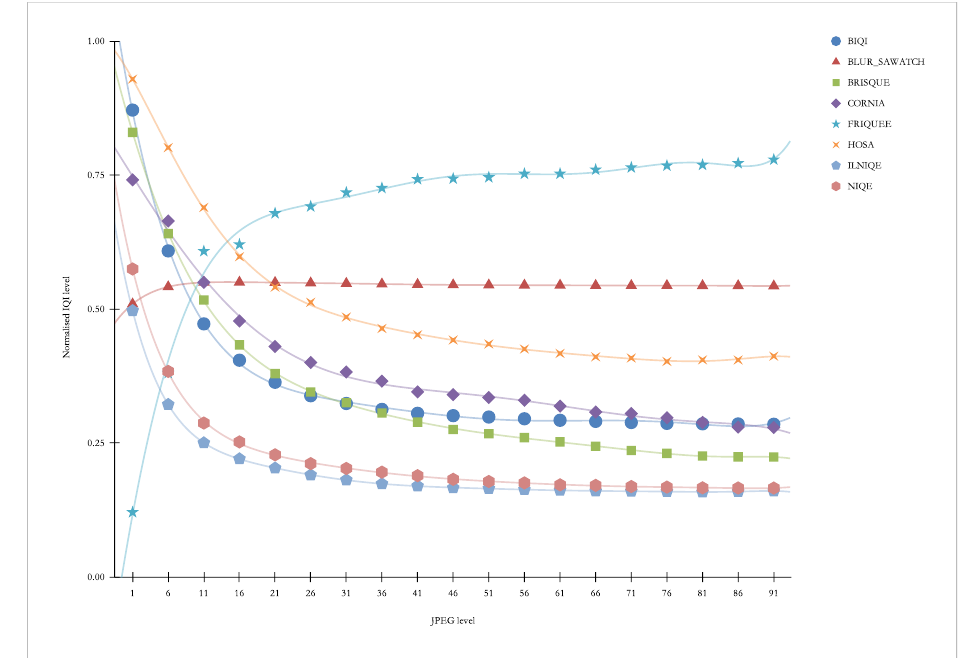
Figure 22. “Other” indicators vs. JPEG [quality